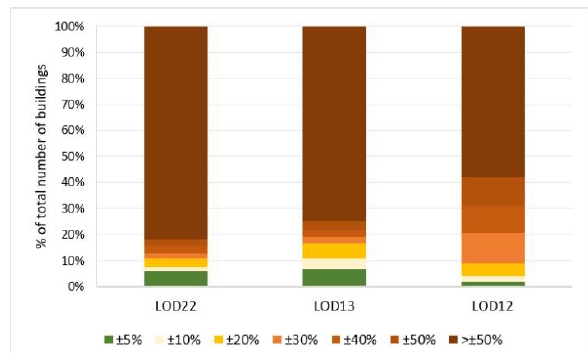
Figure 7. Multi-part buildings (in %) classified according to the respective interval of volume difference from the nDSM.